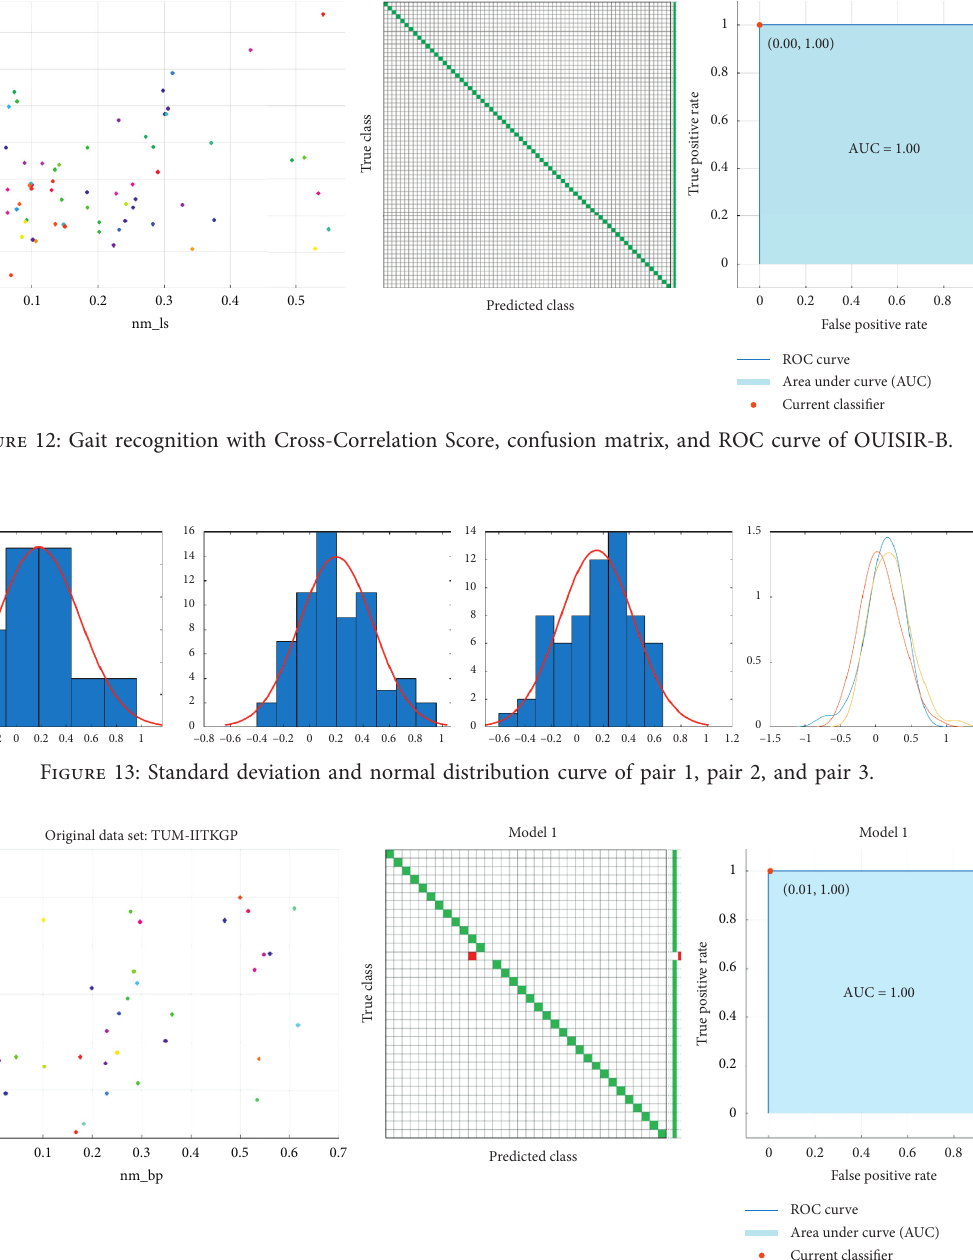
Figure 14: Gait recognition with Cross-Correlation Score, confusion matrix, and ROC curve of TUM-IITKGP.